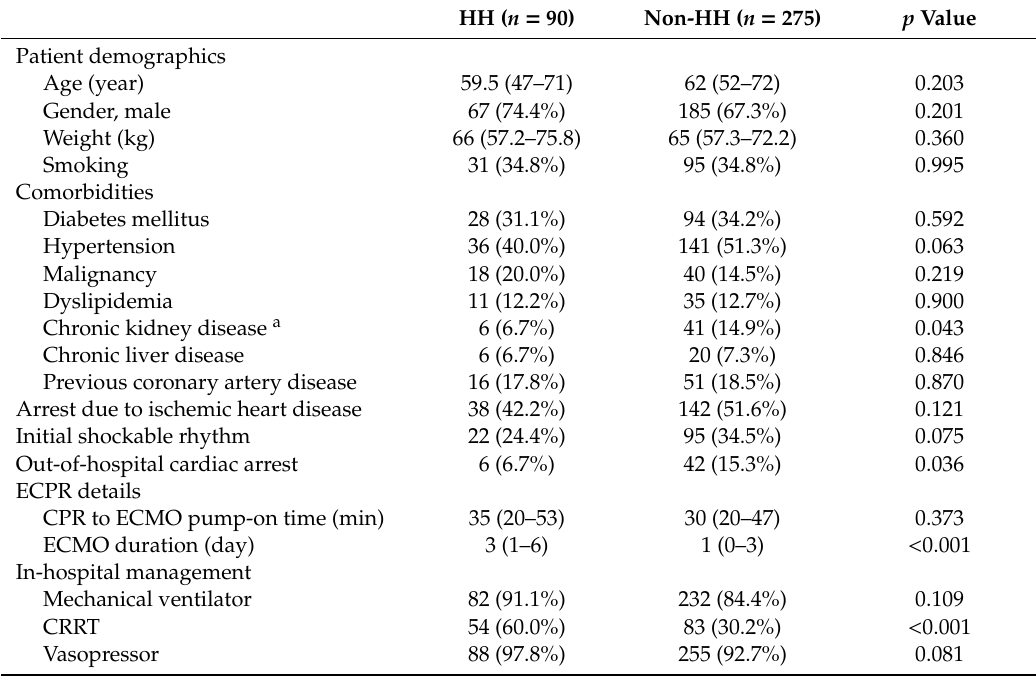
Table 1. Baseline characteristics.